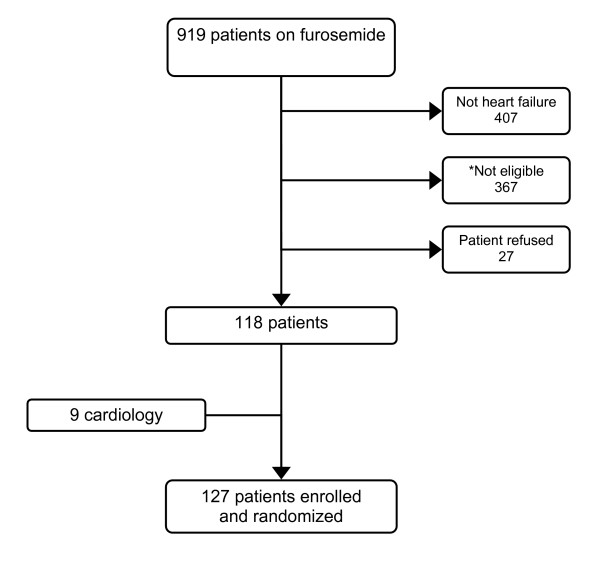
Screening and enrollment results.